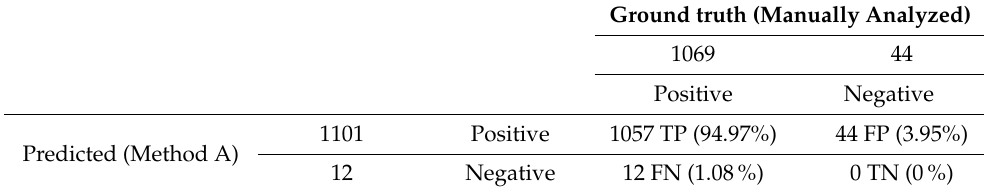
Table 2. Confusion matrix of results obtained by Method A.